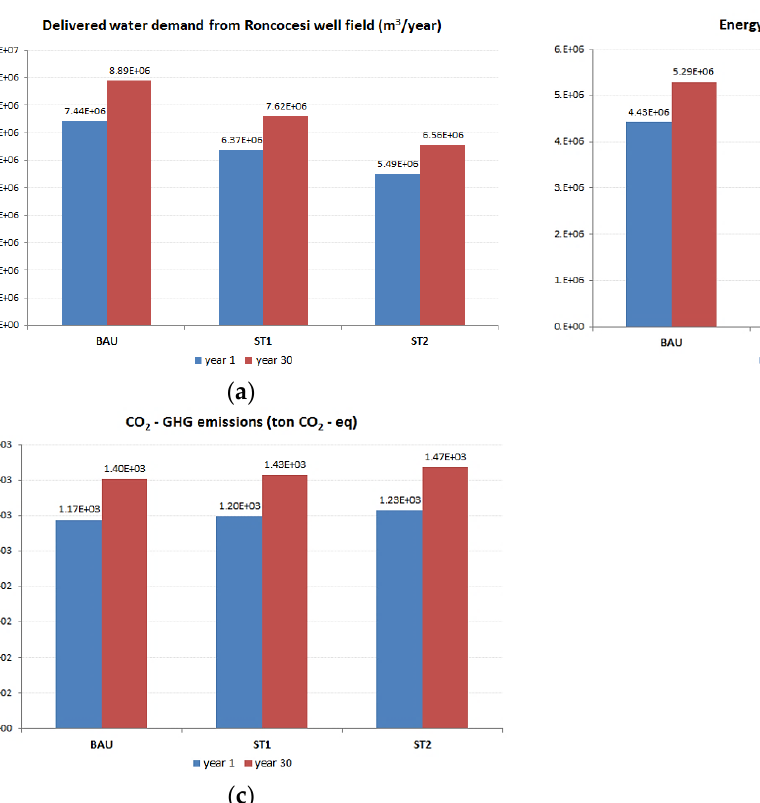
Figure 5. ( a ) Delivered water demand (m 3 /year) from the Roncocesi well field for the 1st and last simulation years and for the three alternative configurations (BAU, ST1, ST2); ( b ) same as ( a ) but referred to the total energy (kWh) consumed by the UWS; ( c ) same as ( a ) but referred to CO 2 emissions (ton CO 2 ‐ eq) produced by the